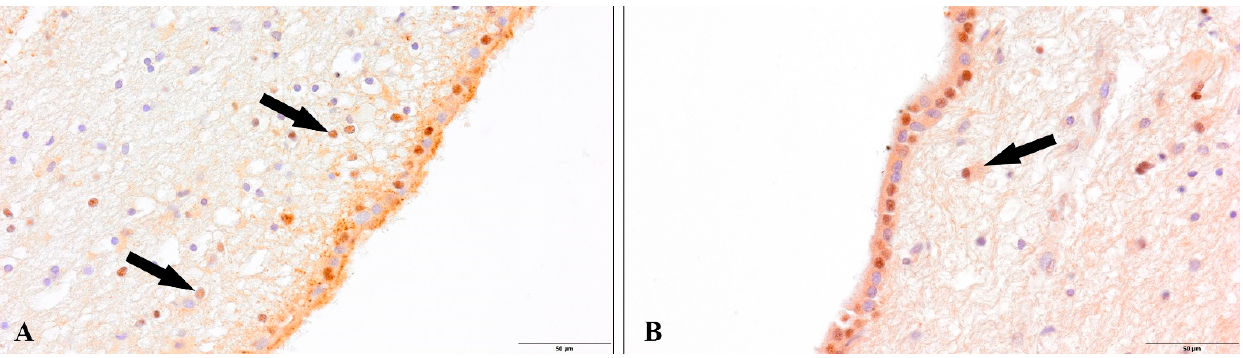
Figure 5. Dentate gyrus, newborn neurons (arrows). ( A ). Control group. ( B ). Group patients with diagnosed COVID-19. Immunolabeling NeuN antibody.